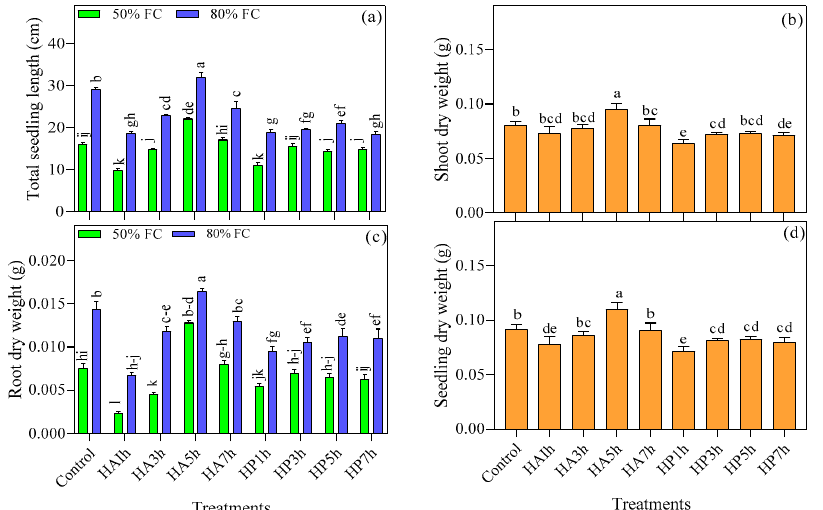
Figure 4. Interaction effect of priming and field moisture level on ( a ) total seedling length (TSL); and ( c ) root dry weight (RDW) and means ( ± SE) followed by the same letters do not differ significantly between treatments x field moisture level using Ls means at p < 0.05. Effect on priming treatment on ( b ) shoot dry weight (SHDW), ( d ) seedling dry weight (SDW) and means ( ± SE) followed by the same letter on the bar do not differ significantly based on LSD at p < 0.05.